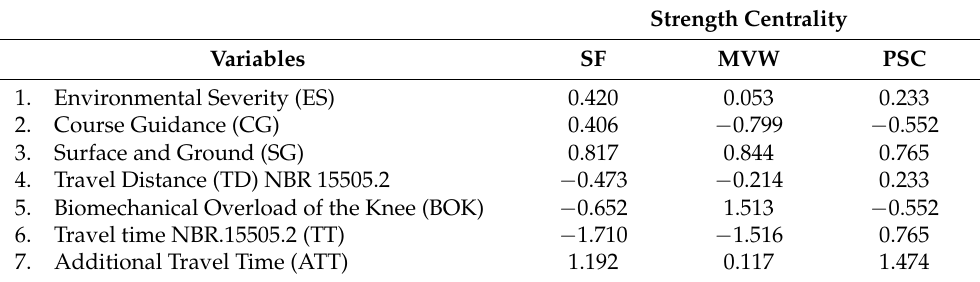
Table 11. Centrality measures of variables to define the network modeling; Araripe UGG.